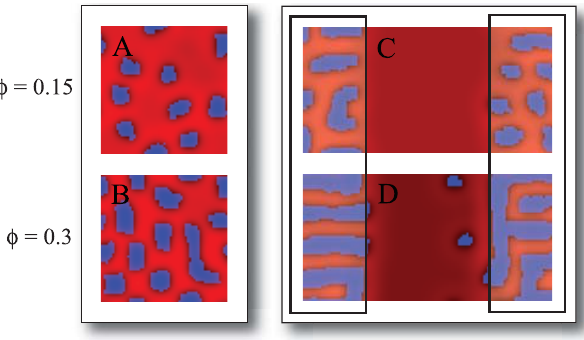
Figure 4. Effect of Membrane Composition on Cluster Formation (A,C) The percentage of lipid A is u ¼ 0.15; the clusters remain approximately the same size as in Figure 2B, with the same lipid and elastic parameters. (C) The rectangles at the left and right represent the poles of the cell with slightly higher curvature c pole ¼ 0.04 nm (cid:1) 1 , as in Figure 3. (B,D) Identical to (A) and (C), respectively, except that u ¼ 0.3.